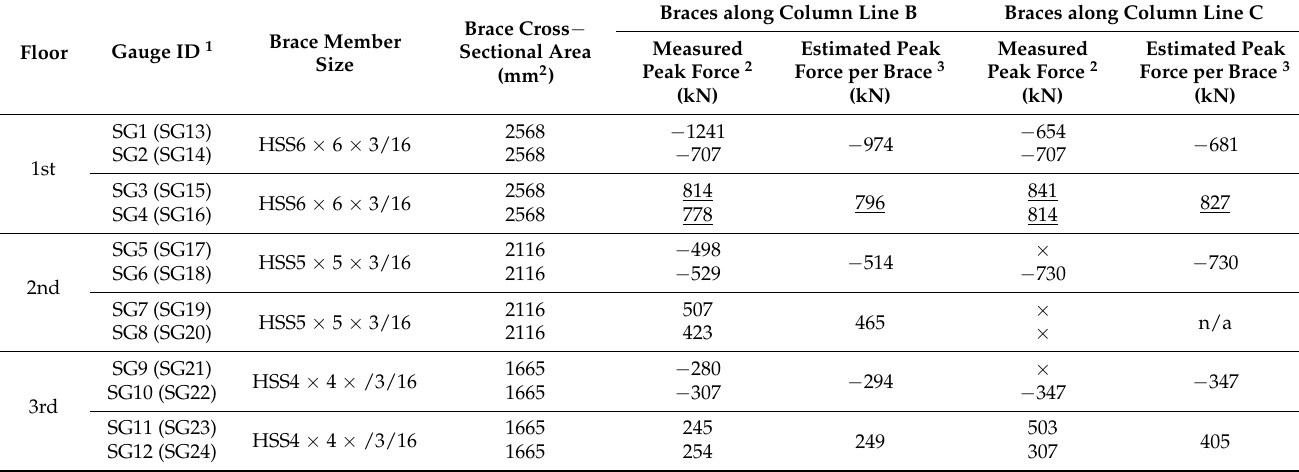
Table 6. Test 2—Peak measured braces forces from strain gauge data (refer to Figure 8 for strain gauge positions).